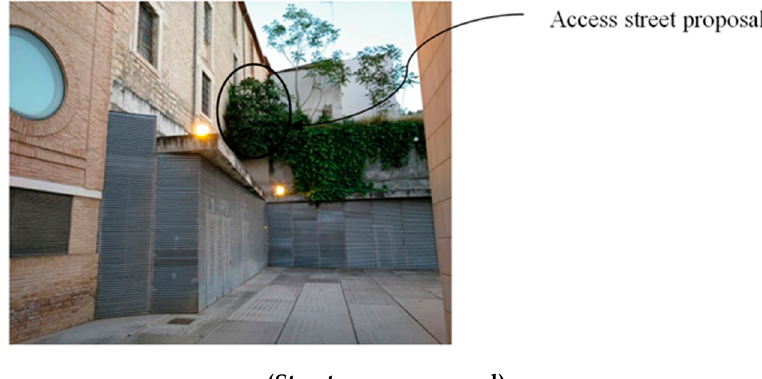
Figure 2. Details of the proposed access to the square from a road at the upper boundary, side view.